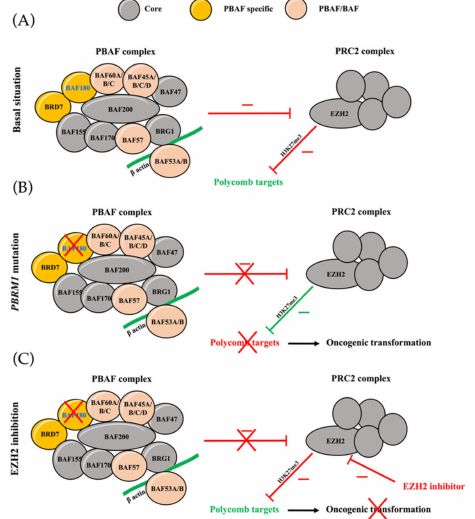
Figure 5. Inter-relationship between PRC2 and SWI/SNF complexes. The SWI/SNF complex is com- posed of 9 to 12 proteins and characterized by an ATPase function via 2 proteins, SMARCA2 (BRM) and SMARCA4 (BRG) which drives nucleosome remodeling. This complex is formed by a constant protein core and also some optional proteins distinguishing 2 types: BAF (BRG1-associated factors) and PBAF (Polychromo-BRG1-associated factors) complexes. ( A ) In basal situation, SWI/SNF com- plexes block the PRC2 complex epigenetic silencing of Polycomb targets; in this basal situation, EZH2 acts as the catalytic subunit of the PRC2 Polycomb repressor complex and catalyzes the trimethylation of histone 3 lysine 27 (H3K27me3) at the promoters of target genes. ( B ) Perturbations in SWI/SNF activity, such as the loss of the specific subunit PBRM1 (BAF180), lead to oncogenesis via imbal- anced PRC2 activity and aberrant epigenetic silencing of Polycomb targets. ( C ) The EZH2-inhibor re-establishes the balance between the complexes by inhibition of EZH2 methyltransferase